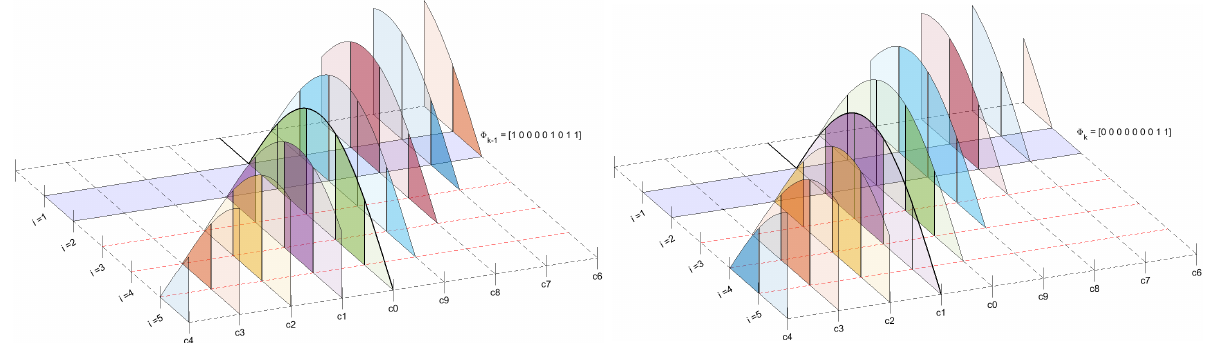
Figure 5: Illustration of the chamber actuation decisions in the prediction horizon for sample k − 1 and k . Those areas shown with a dark color illustrate an active